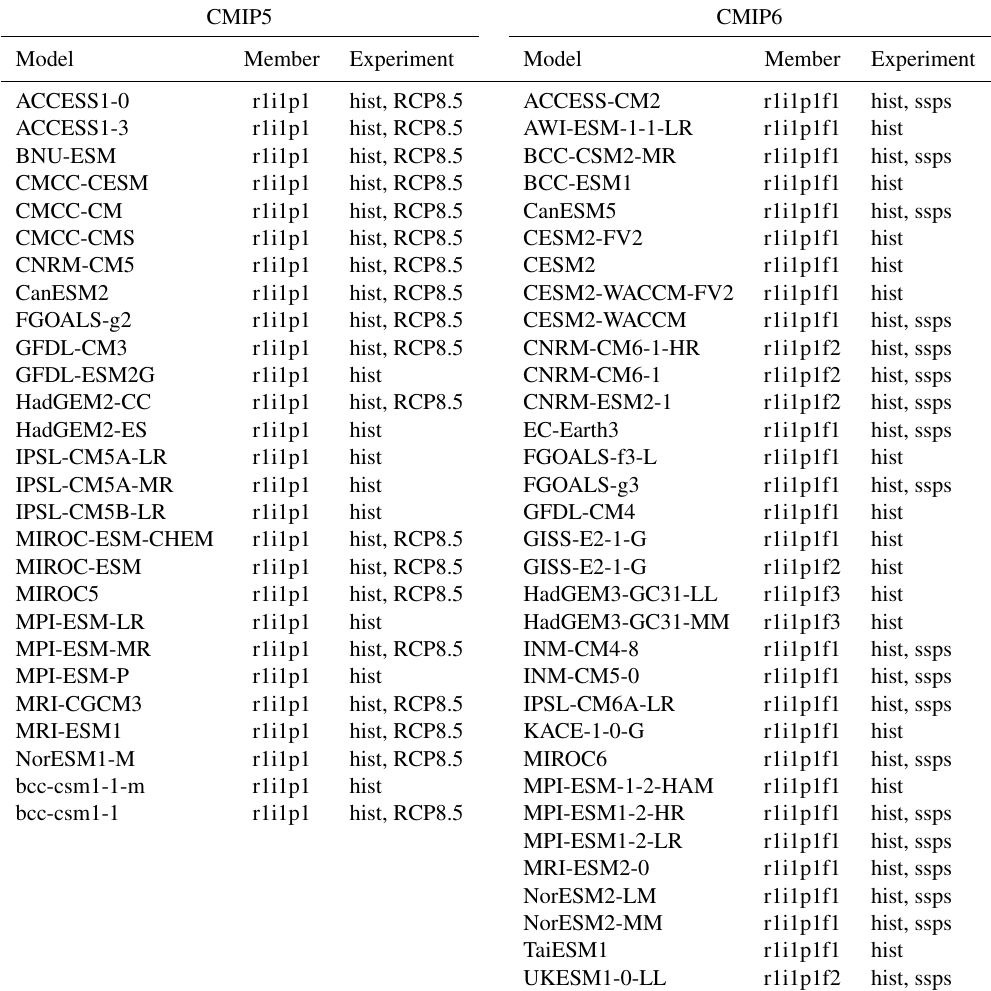
Table 1. Models and ensemble members used in the analysis. Hist stands for historical simulation, and ssps means that SSP1–2.6, SSP2–4.5, SSP3–7.0 and SSP5–8.5 were all analysed for that model/member (for